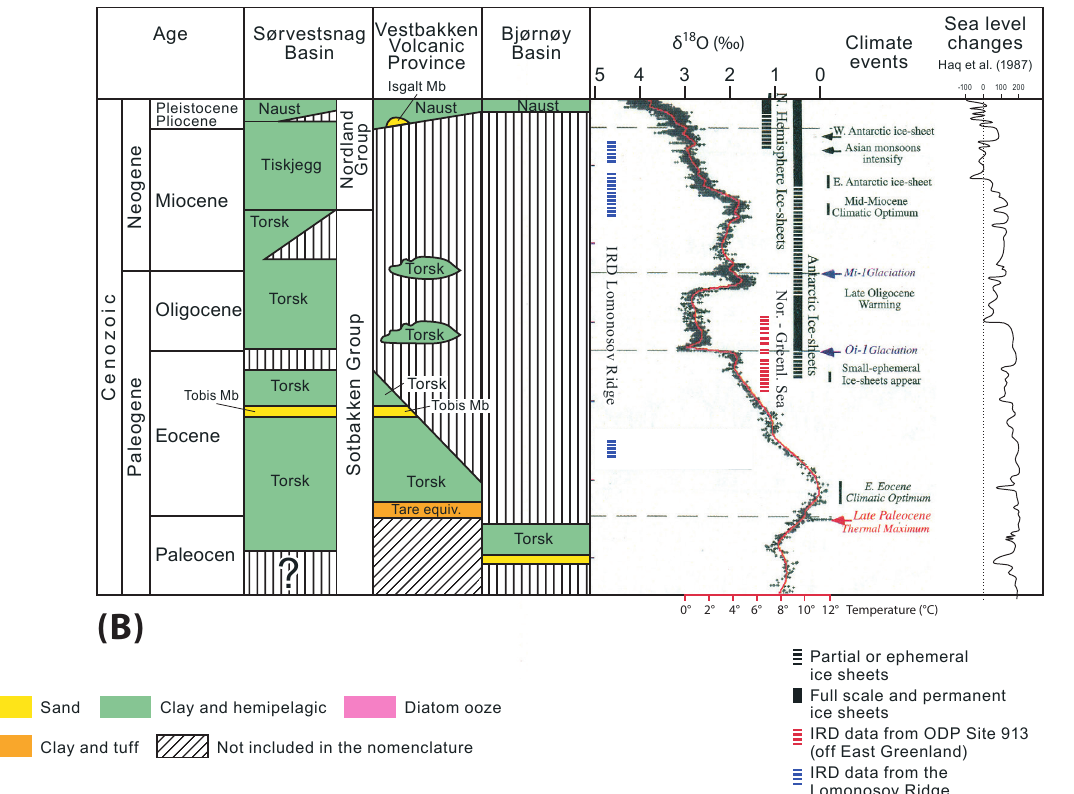
Not included in the